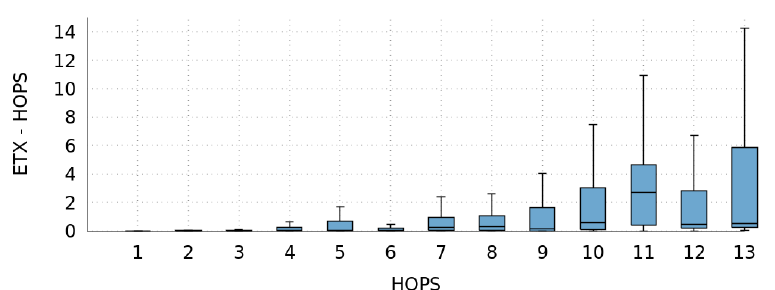
Figure 7. Deviation between average ETX and hops normalized by the corresponding number of hops.